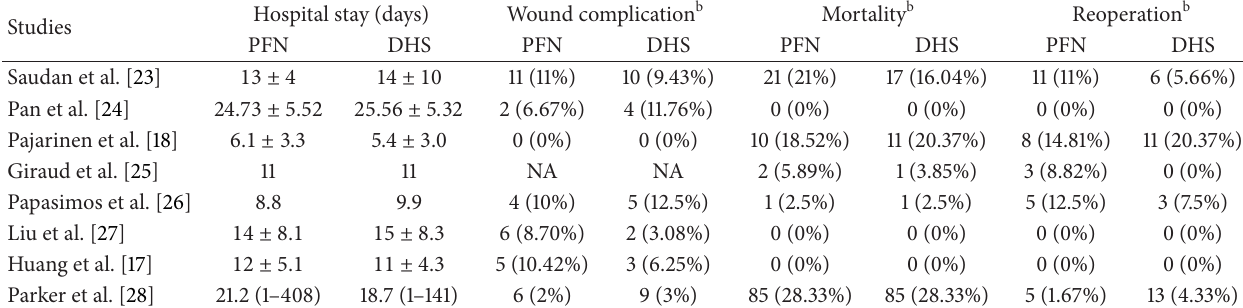
Table 4: Postoperative outcomes of the two